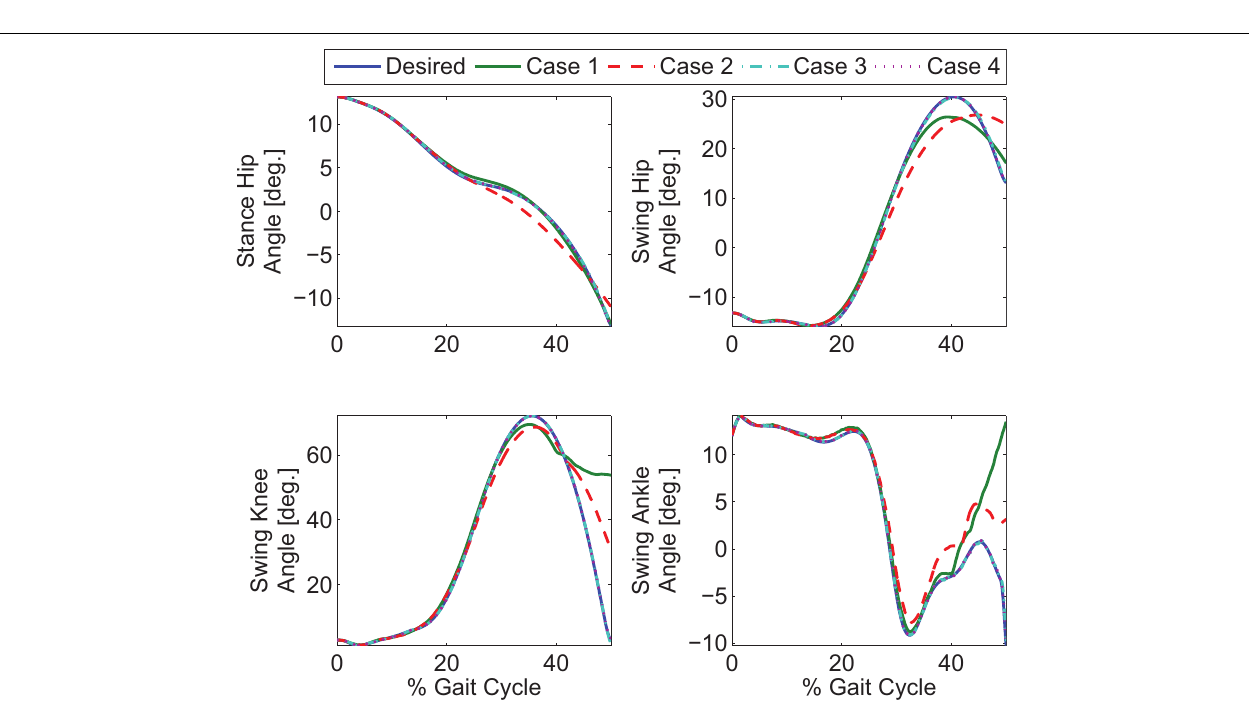
FIGURE 5 | (A) Two synergies, w 1 and w 2 . (B) The corresponding time-varying activation coefficients, c 1 and c 2 , of synergies, w 1 and w 2 .